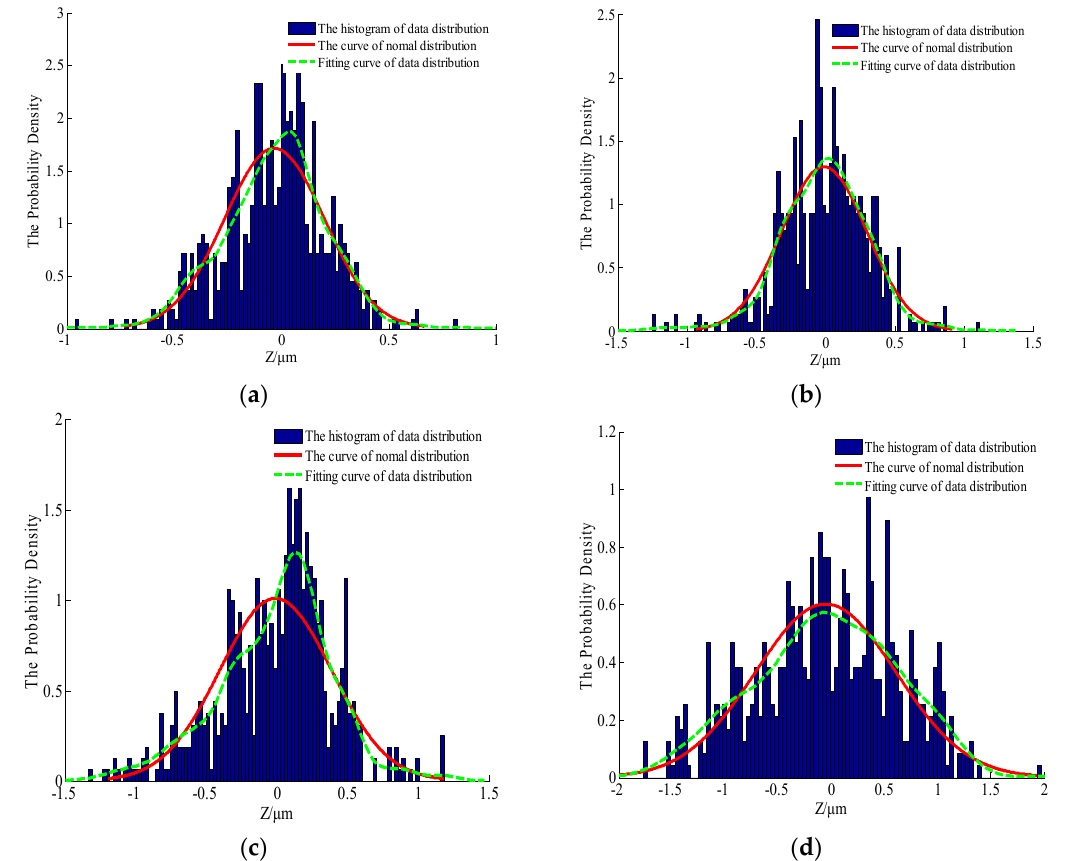
Figure 7. The probability density graphs for different surface morphologies ( a ) The upper surface of the specimen 1; ( b ) The lower surface of the specimen 2; ( c ) The upper surface of the specimen 3 and ( d ) The lower surface of the specimen 4.